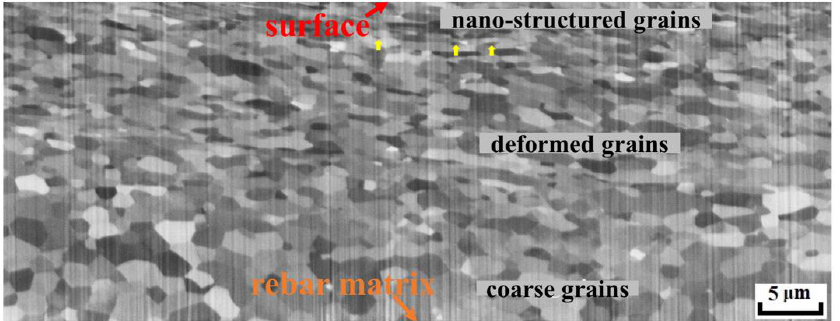
Figure 11. SEM image of the gradient microstructure of the SNC rebar obtained by FIB cutting.